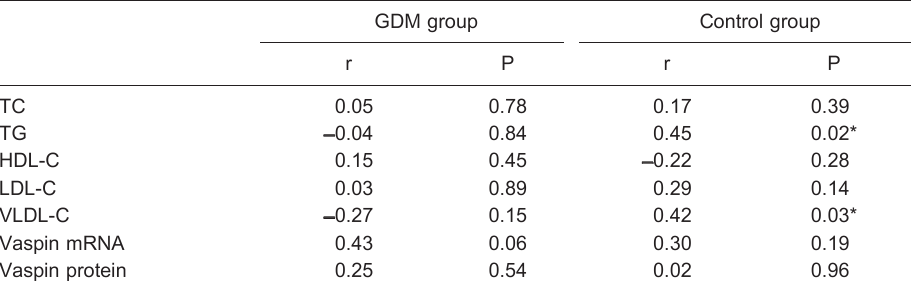
Data are reported as means±SE. TC: total cholesterol; TG: triglycerides; HDL-C: high-density lipoprotein cholesterol; LDL-C: low-density lipoprotein cholesterol; VLDL-C: very-low-density lipoprotein